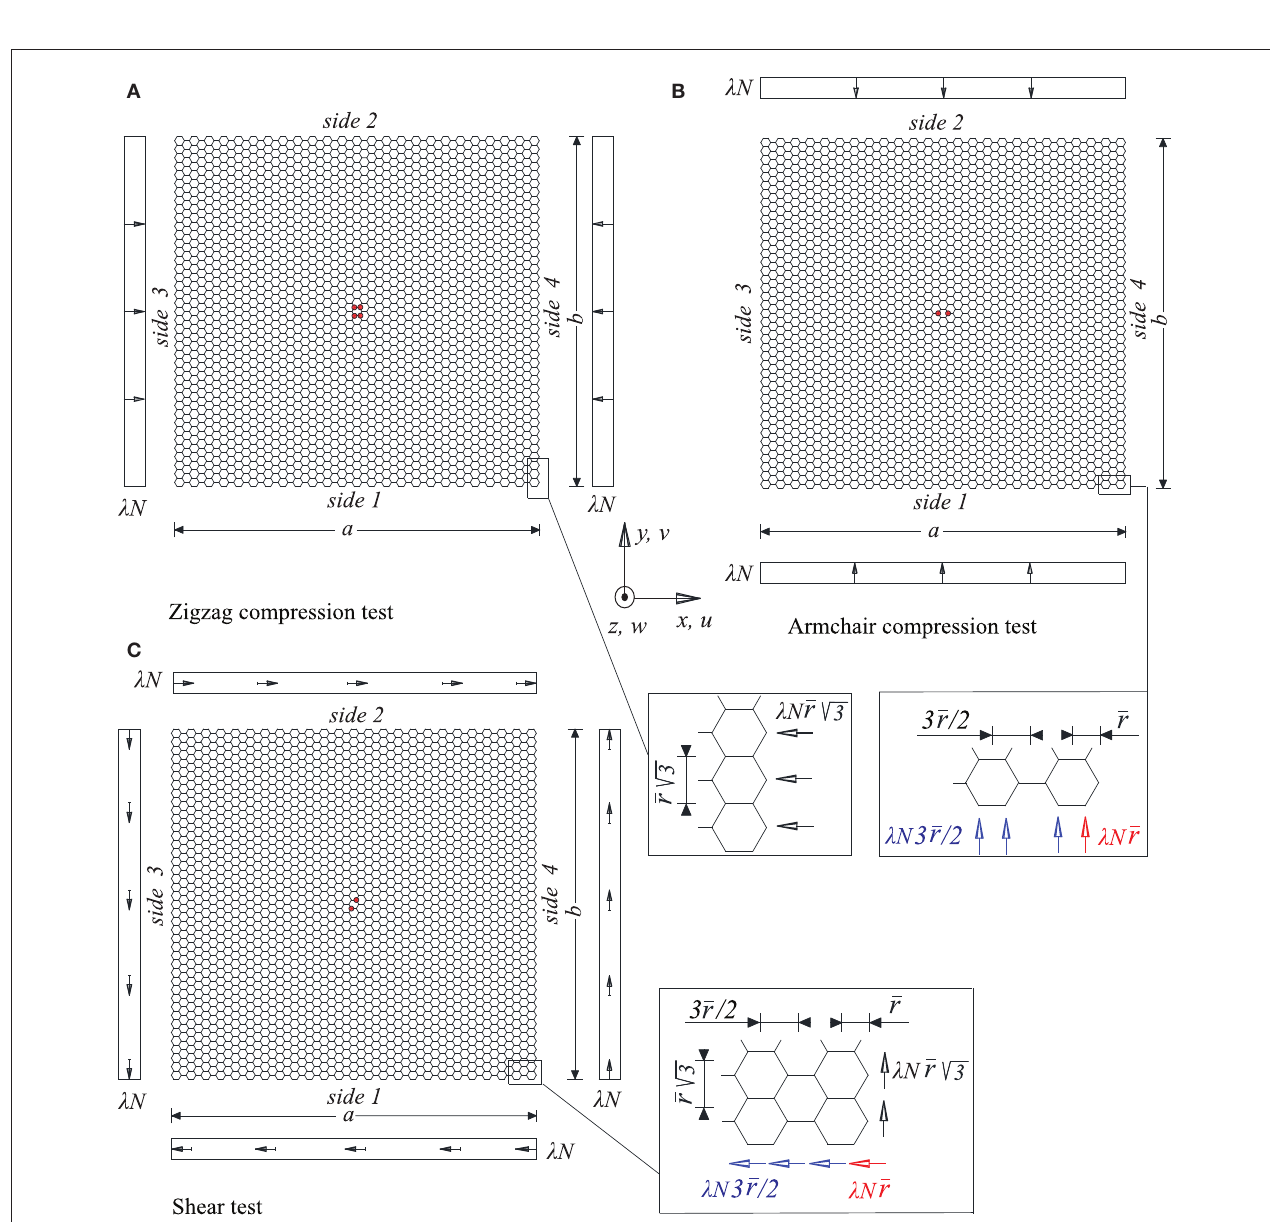
FIGURE 2 | Schemes of the compression and shear tests of the nearly square graphene sheet: (A,B) geometry and details of the applied loads for the compression tests in the zigzag and in the armchair directions, (C) geometry, and details of the applied loads for the shear test.